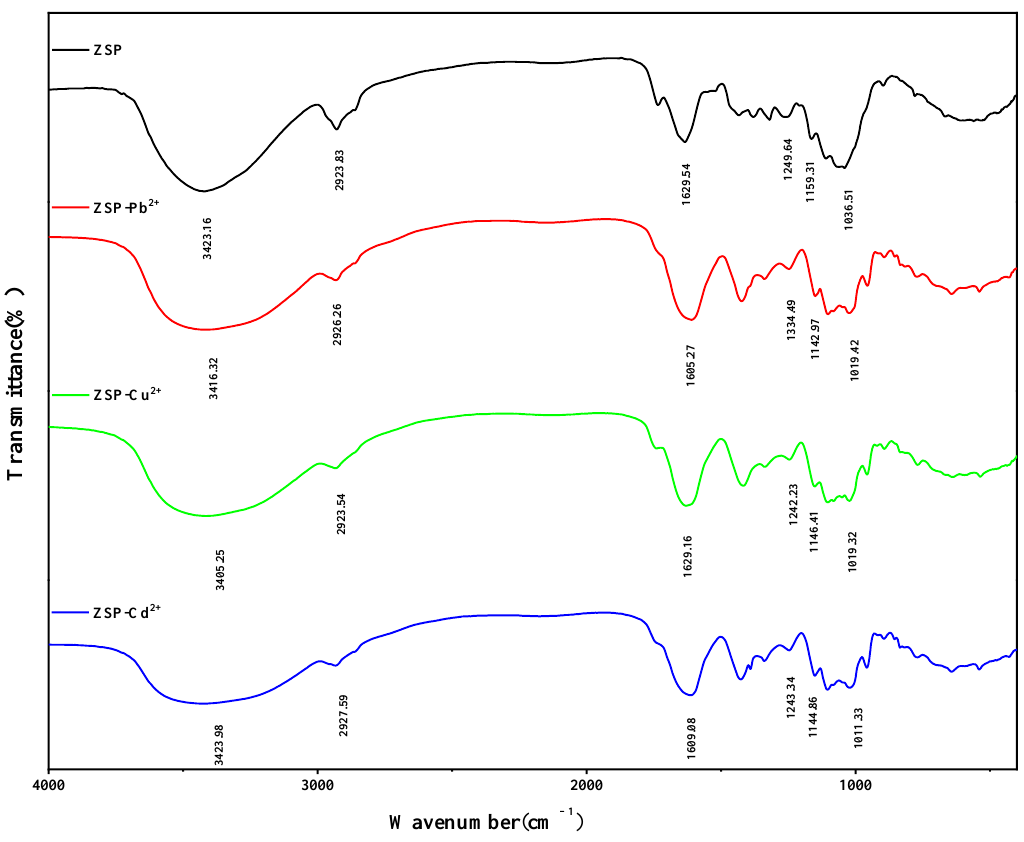
Figure 7. FT-IR spectra of ZSP and ZSP loaded with Pb 2+ , Cu 2+ and Cd 2+ . Table 3. Wave numbers (cm − 1 ) of dominant peaks obtained from FT-IR transmission spectra of ZSP + Pb 2+ , Cu 2+ , Cd 2+